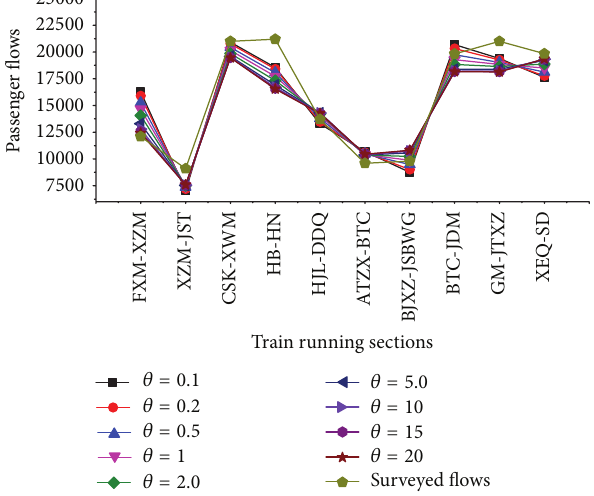
Figure 7: Impacts of 𝜃 in assignment results of train running